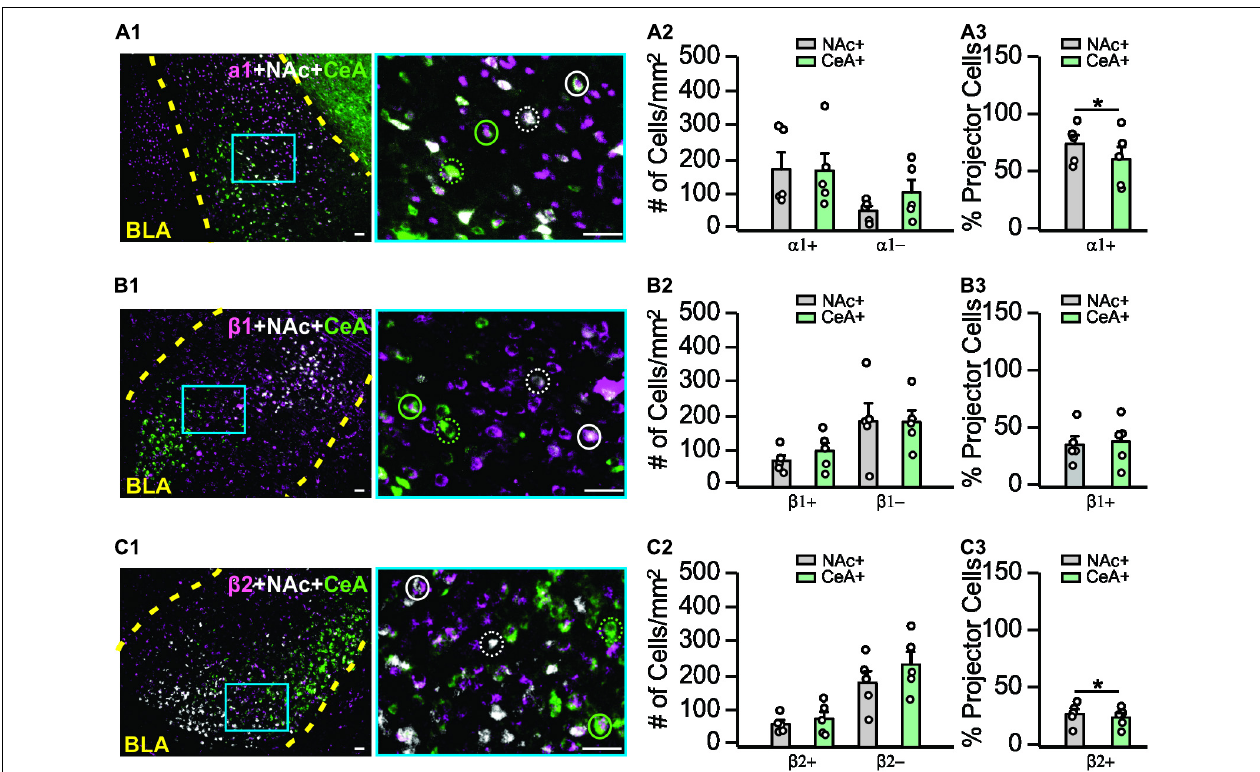
FIGURE 3 | Adrenoceptor subtype expressions in the basolateral amygdala. (A1–A3) Expression patterns of α 1 -adrenoceptors in the BLA and co-labeling with NAc- or CeA- projecting cells. (A1) Example image of α 1 -adrenoceptor staining (magenta), NAc- (white), and CeA- (green) projecting cells are indexed by CTB. Image on the right is the zoom in image of the area indicated by the blue square on the left image. Solid circles, α 1 + projecting cells. Dashed circles, α 1 - projecting cells. (A2) Numbers of α 1 + and α 1 - NAc- and CeA-projecting cells. (A3) Percentage of α 1 + projecting neurons over the total projecting neurons. (B1–B3) Expression patterns of β 1 -adrenoceptors in the BLA and co-labeling with NAc or CeA projecting cells. Solid circles, β 1 + projecting cells. Dashed circles, β 1 - projecting cells. (C1–C3) Expression patterns of β 2 -adrenoceptors in the BLA and co-labeling with NAc- or CeA-projecting cells. Solid circles, β 2 + projecting cells. Dashed circles, β 2 - projecting cells. Scale bars: 50 µ m. * p <